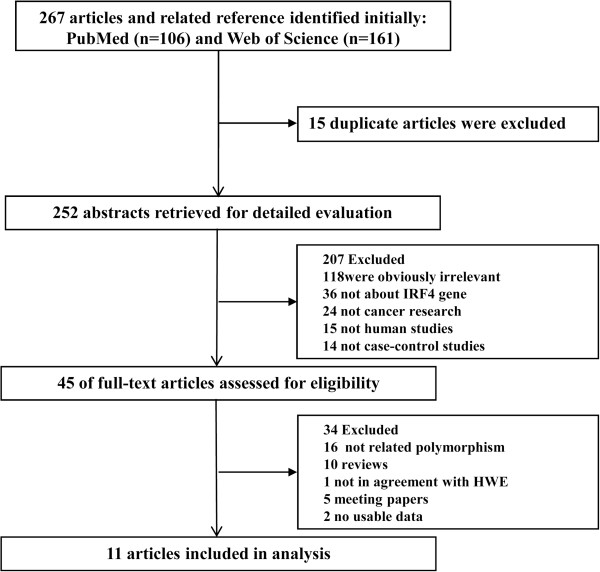
Flow chart of literature search and study selection.